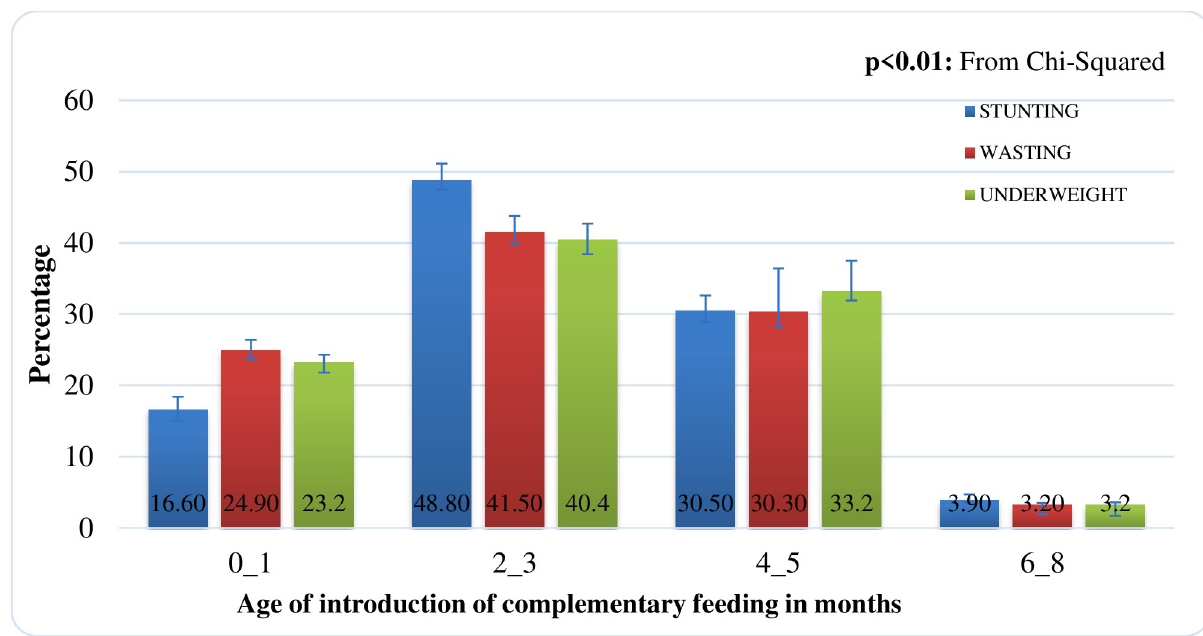
Fig 6. Proportion of children with undernutrition with respect to age category at which complementary feeding was introduced.